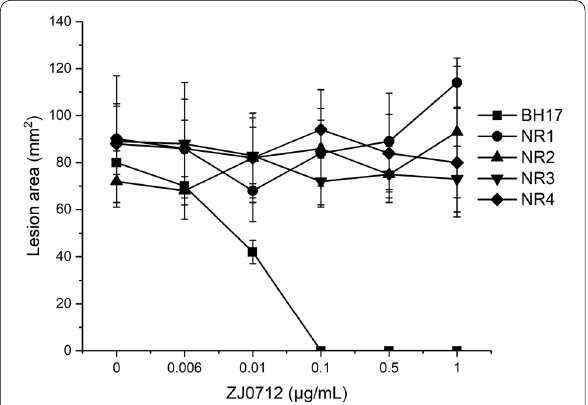
Fig. 2 Dose–response curves showing ZJ0712 sensitivity of sensitive Podosphaera xanthii isolate BH17 and resistant isolates (NR1,